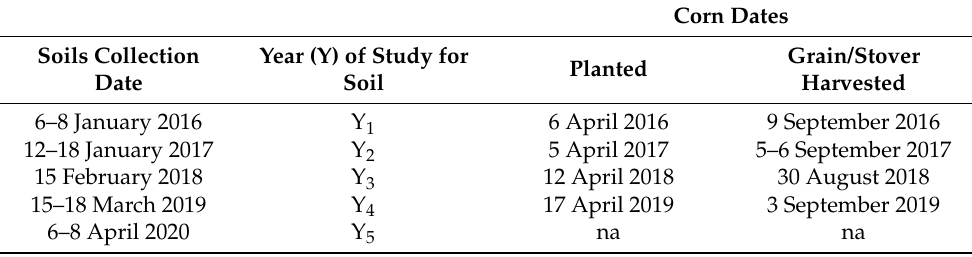
Table 2. Research timeline for collection of soils for fertility measurements, corn planting and grain/stover harvesting dates (biochar applied to plots on 1–2 February 2016; na = not